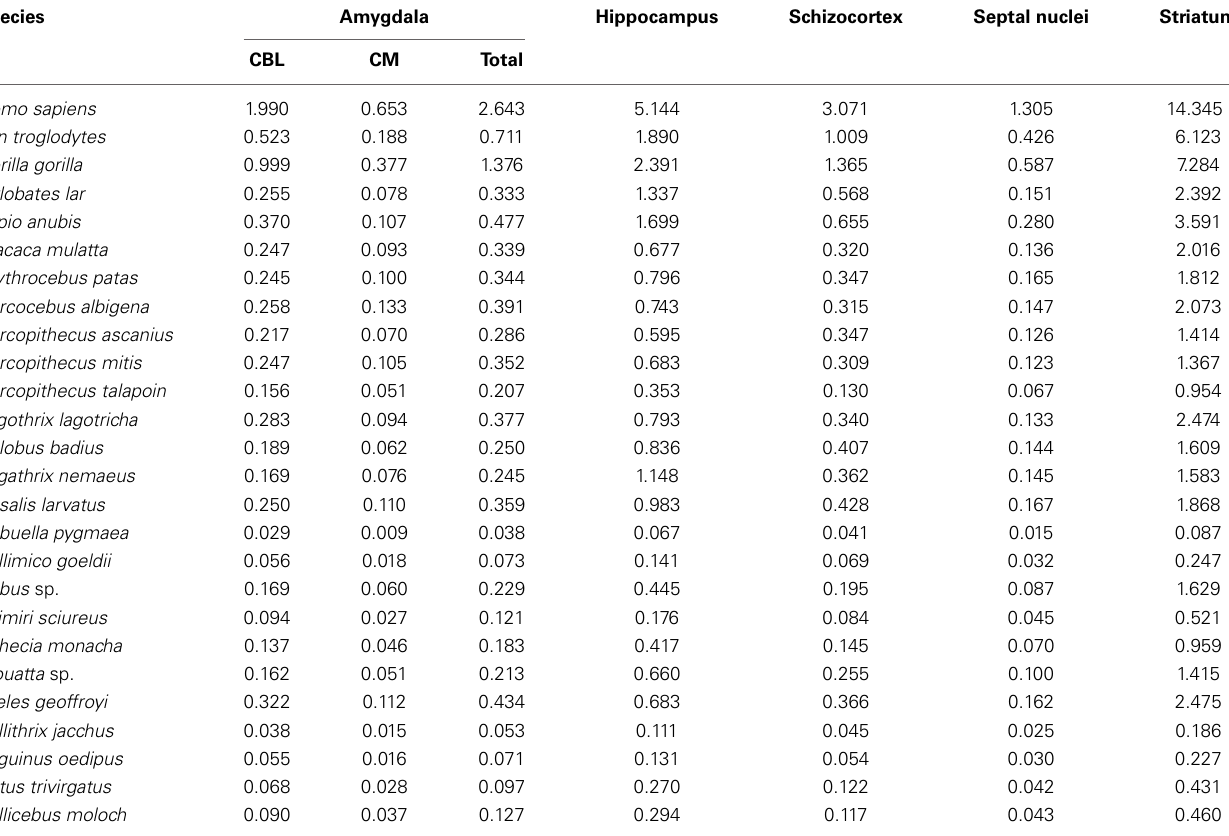
Table 3 | Volume of the amygdala (Stephan et al., 1987), hippocampus, schizocortex, septal nuclei, and striatum (Stephan et al., 1981) in